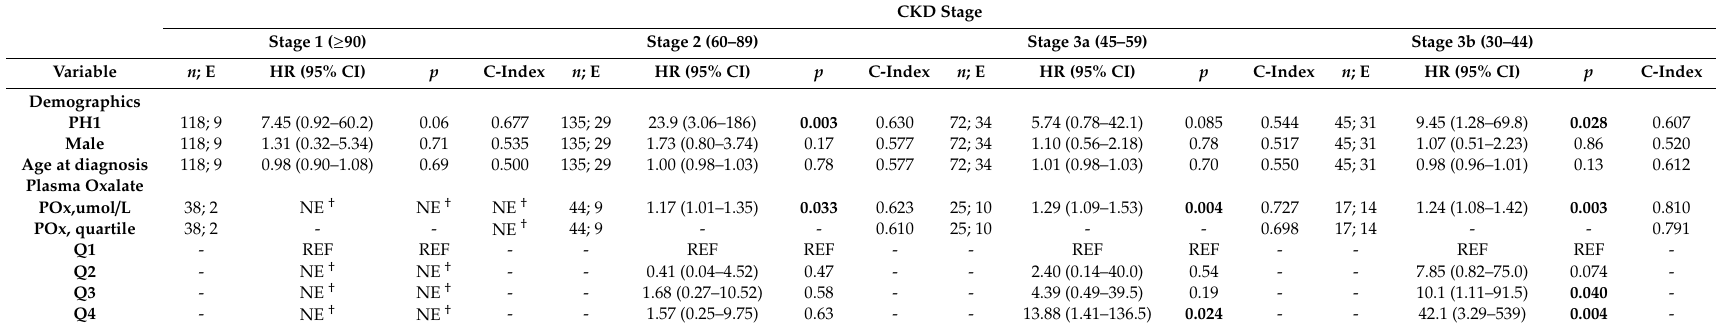
Table 3. Factors univariately associated with incident ESKD among patients with primary hyperoxaluria without ESKD at baseline.